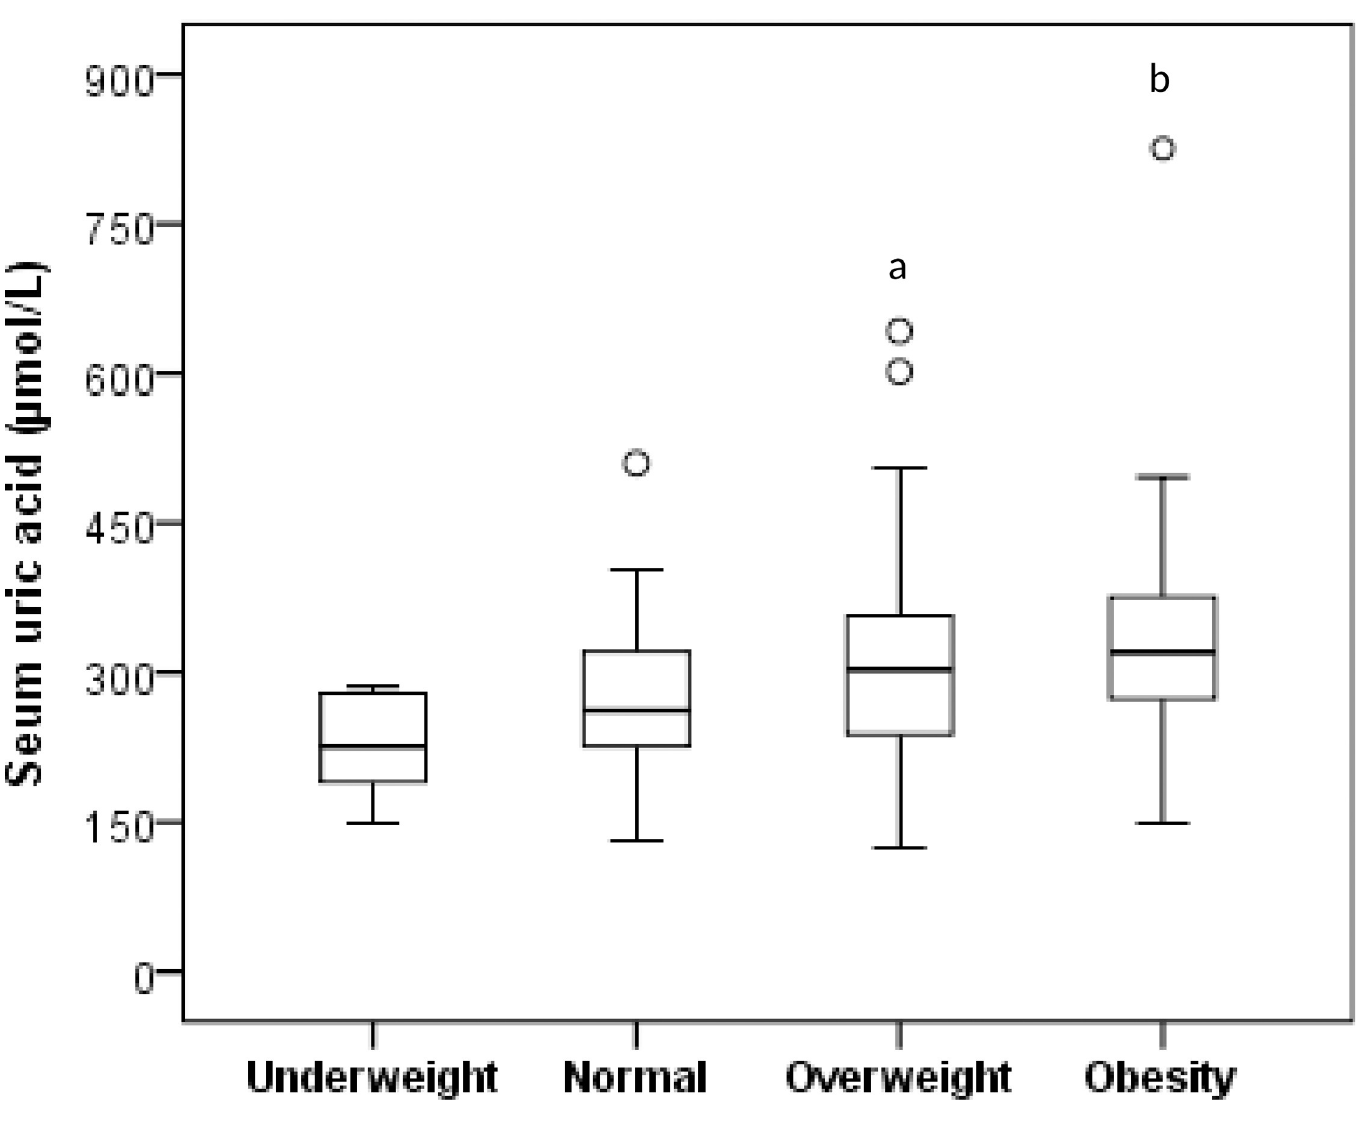
Fig 2. Level of serum uric acid in different BMI (kg/m 2 ) groups. Based on diagnostic criteria for obesity for Asian populations recommended by the WHO, BMI has been categorized into four groups: underweight ( < 18.5), normal weight (18.5–23.0), overweight (23.0–27.5), and obese ( � 27.5) [32]. a p < 0.05 and b p < 0.01 when compared to the underweight